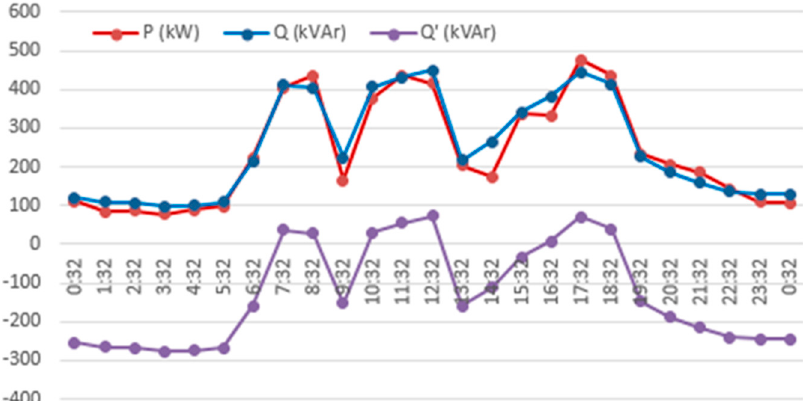
Figure 4. Active ( 𝑃 ) and reactive ( 𝑄′ ) powers delivered by the transformer on working days, as well as the reactive powers ( 𝑄 ) supplied without capacitor banks. (Negative sign indicates capacitive reactive powers).